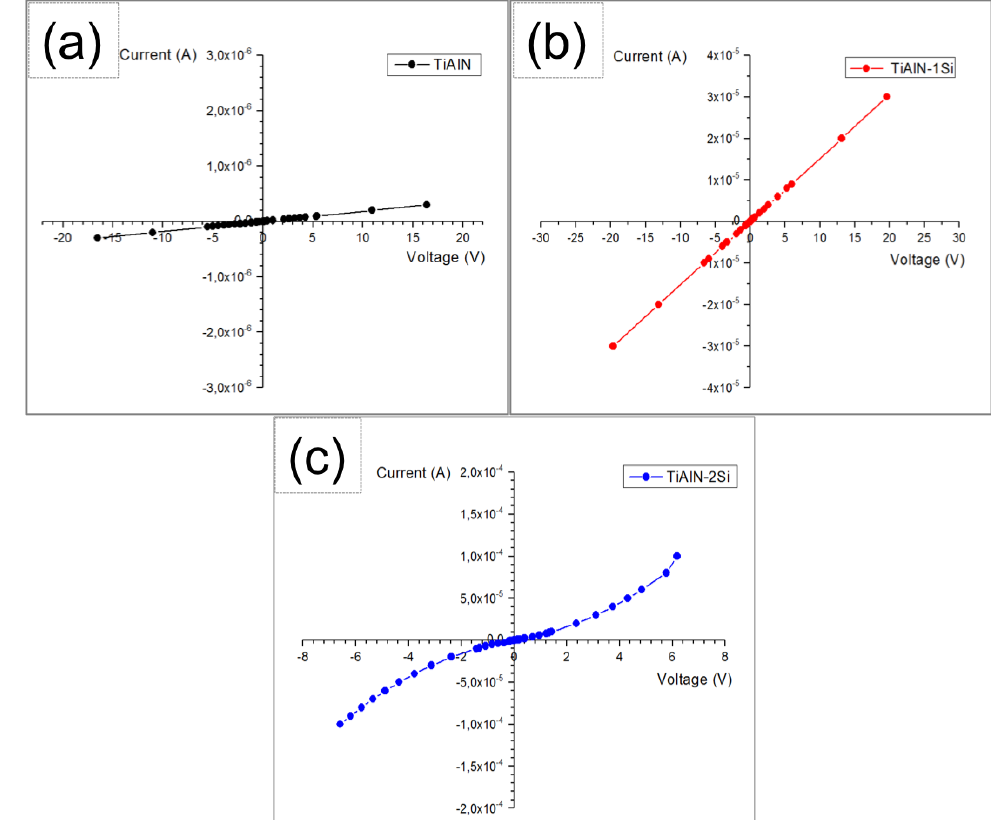
Figure 5. Current vs voltage of the (Al,Ti,Si)N films deposited on common glass (a) without Si, (b) 1 piece of Si and c- 2 Si.